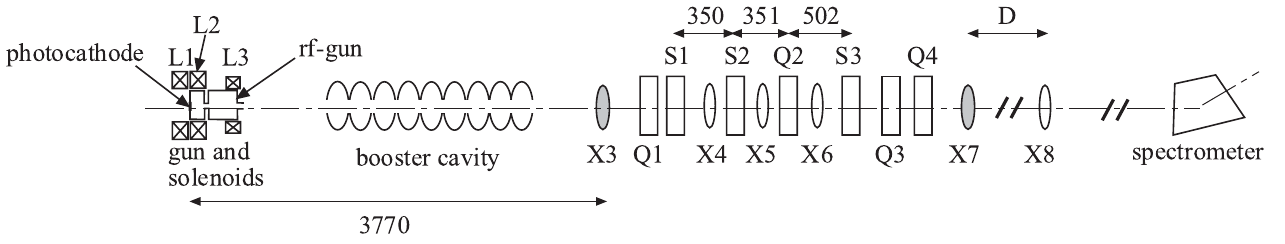
FIG. 1. Overview of the Fermilab/NICADD photoinjector. ‘‘X’’ refer to diagnostics stations (beam viewers, and/or slit location), ‘‘L’’ to the solenoidal lenses, ‘‘Q’’ to quadrupoles, and ‘‘S’’ to the skew quadrupoles. All distances are in mm, with D (cid:6) 800 (or 1850 for the data presented in Fig.